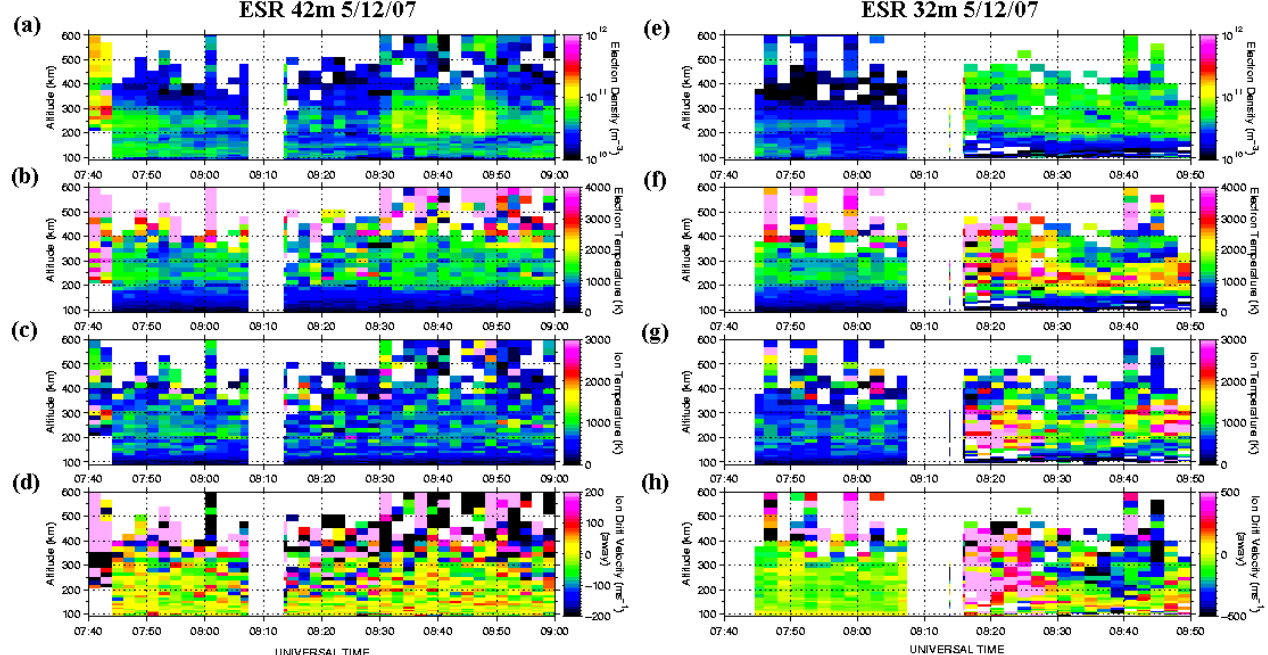
Fig. 9. ESR results from 5 December 2007 for 07:40UT to 09:00UT, 42m is field-aligned (a–d) , while the 32m (e–h) points to the south before 08:10UT and then near north afterwards (as indicated in Fig. Figure 9: ESR results from 5/12/07 for 0740 UT to 0900 UT, 42m is field-aligned (a-d), while the 32m (e-h) points to the south before 0810 UT and then near north afterwards (as indicated in Figure 1).